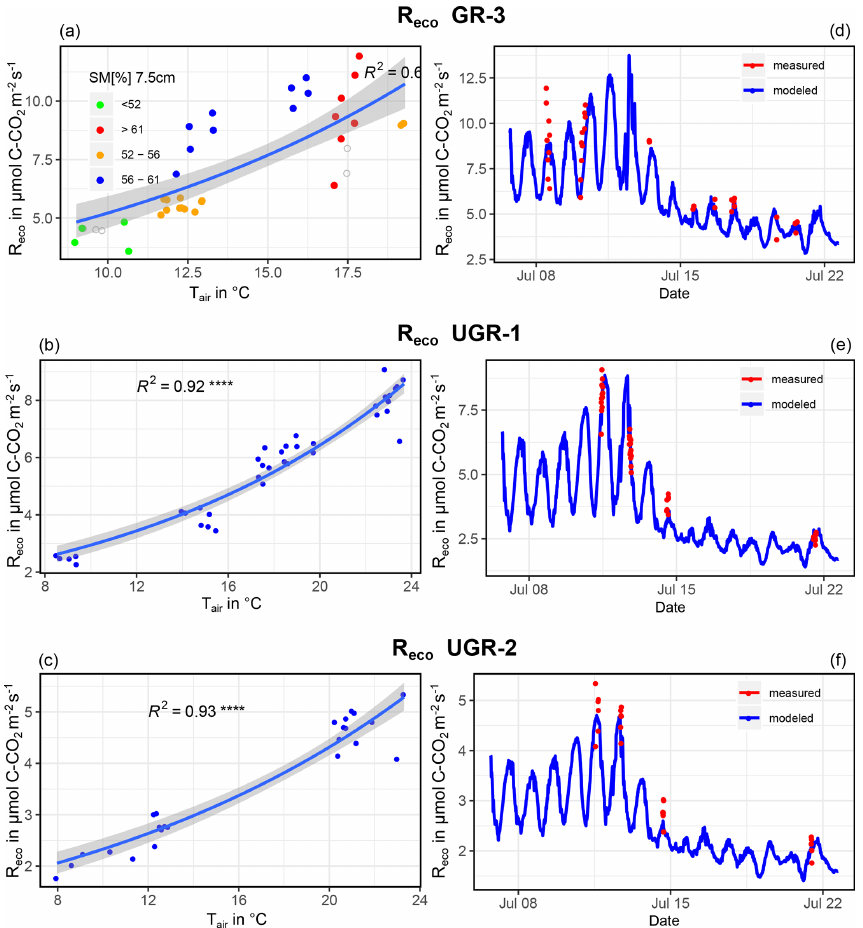
Figure B2. Depiction of the relationship between T air and R eco for GR-3 (a) , UGR-1 (b) and UGR-2 (c) . Interpolation models are formed by the equation of the depicted regression curve. The graphs on the right (d, e, f) show modeled vs. measured fluxes.